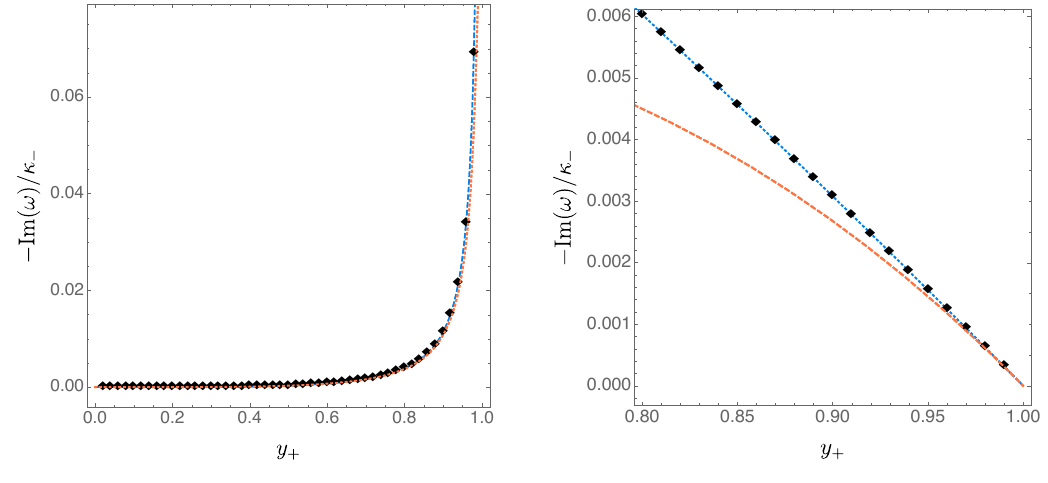
Figure 9 . Photon sphere family of modes (cid:8) (cid:0) with ‘ = 2, n = 0 and the Nariai limit. In both plots, the dashed orange line refers to the Nariai analytical prediction (A.2) for (cid:0) Im( ! Nariai ) =(cid:20) (cid:0) (with ‘ = 2 ; n = 0), while the dotted blue curve is the analytical photon sphere prediction (5.11) for (cid:0) Im( ! WKB ) =(cid:20) (cid:0) (with n = 0). Left panel: (cid:0) Im( ! ) =(cid:20) (cid:0) as a function of Q=Q ext at (cid:12)xed y + = 0 : 99, i.e. r + = 0 : 99 r c . Right panel: (cid:0) Im( ! ) =(cid:20) (cid:0) as a function of y + at (cid:12)xed Q=Q ext = 0 : 4995. Note